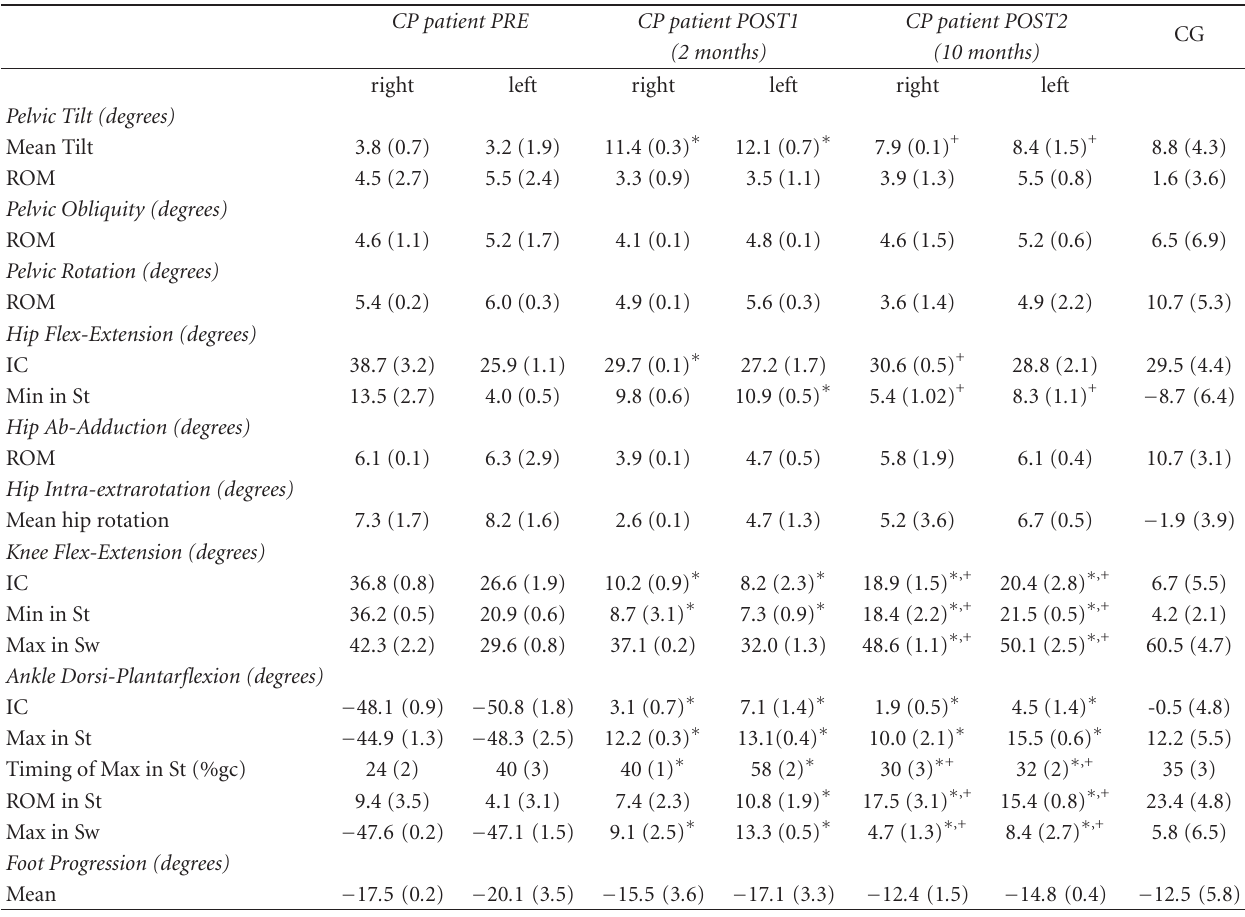
Table 2: Summary of kinematic parameters (mean and standard deviation) for analysed patient (CP patient; right and left side) in the examined sessions and normative data (Control Group,